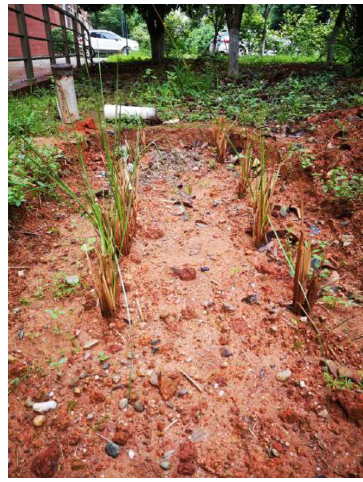
Figure 5. Growth process of vetiver grass.